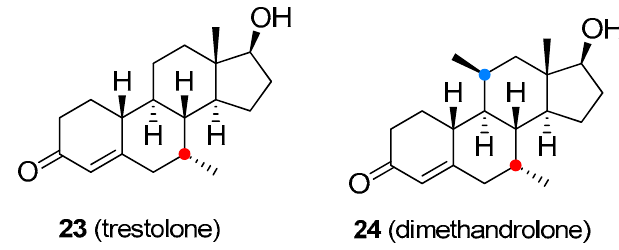
Figure 5. Experimental androgen-anabolic steroids.